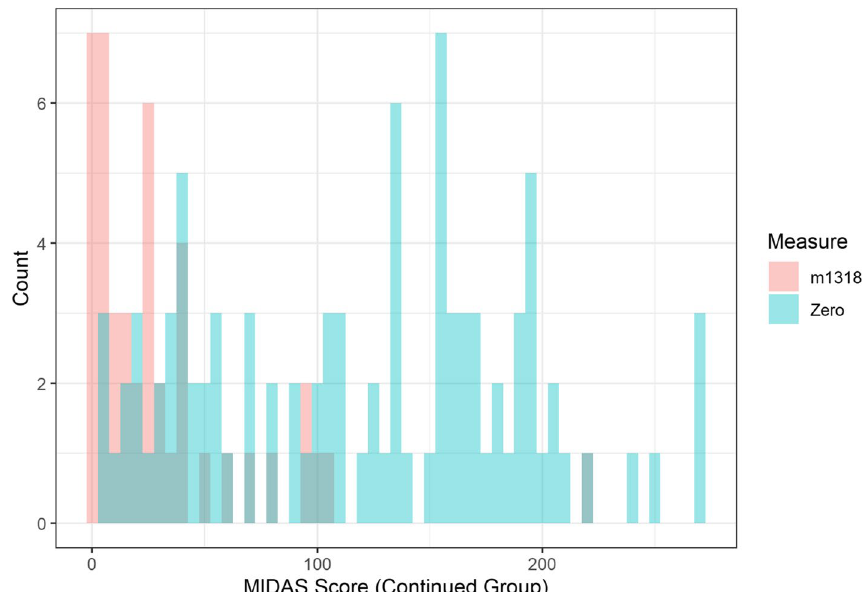
Fig. 5 Histogram comparing times Zero and m1318 distribution of MIDAS scores for patients who remained on treatment beyond June 2021